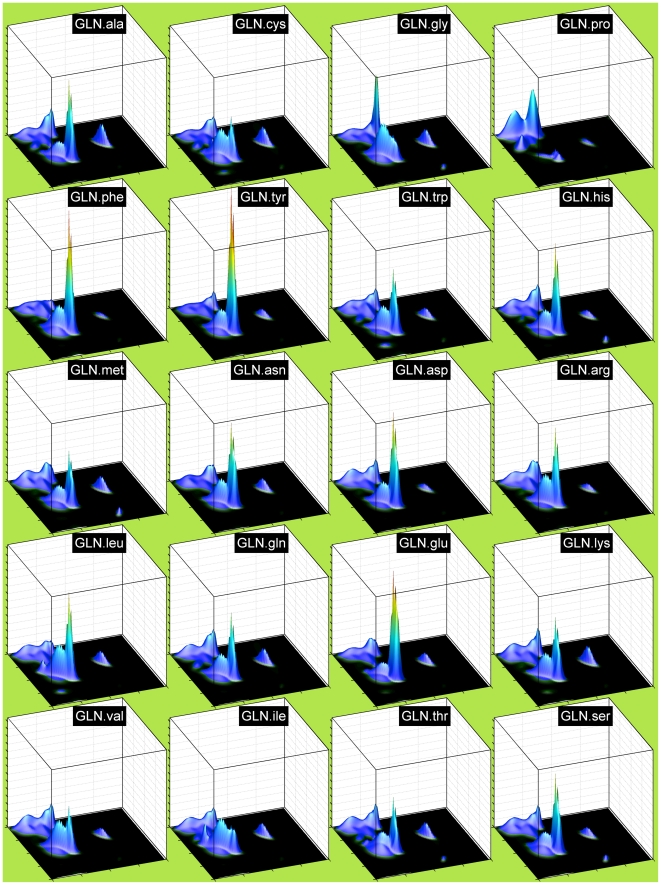
Right neighbor-dependent Ramachandran distributions of glutamine with each of 20 amino acid types as right neighbors.All plots are scaled to a common maximum probability height.